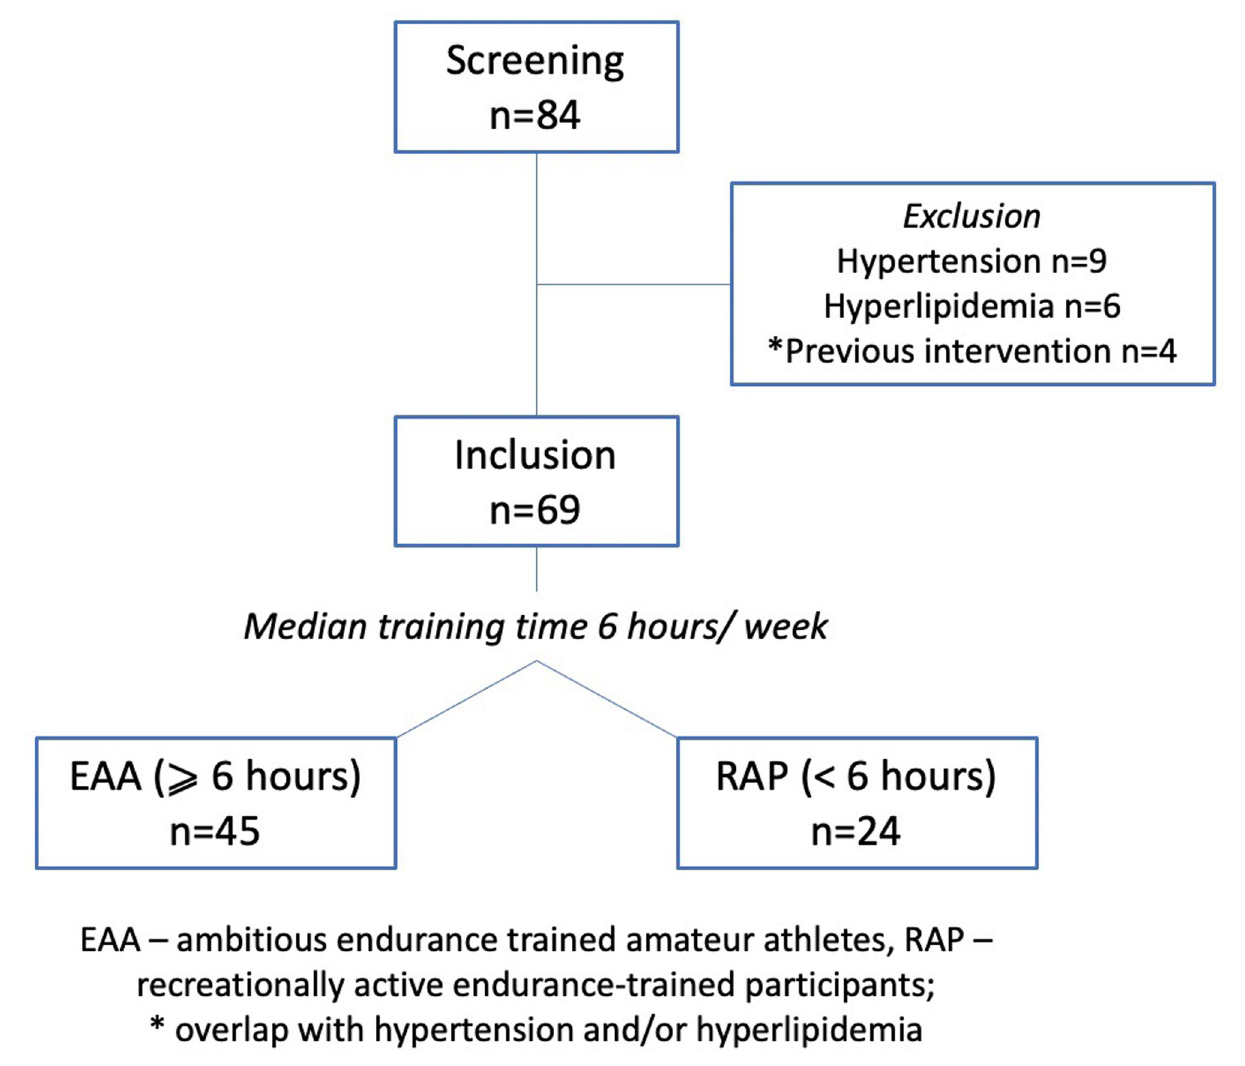
Fig 1. Flow-chart of the inclusion